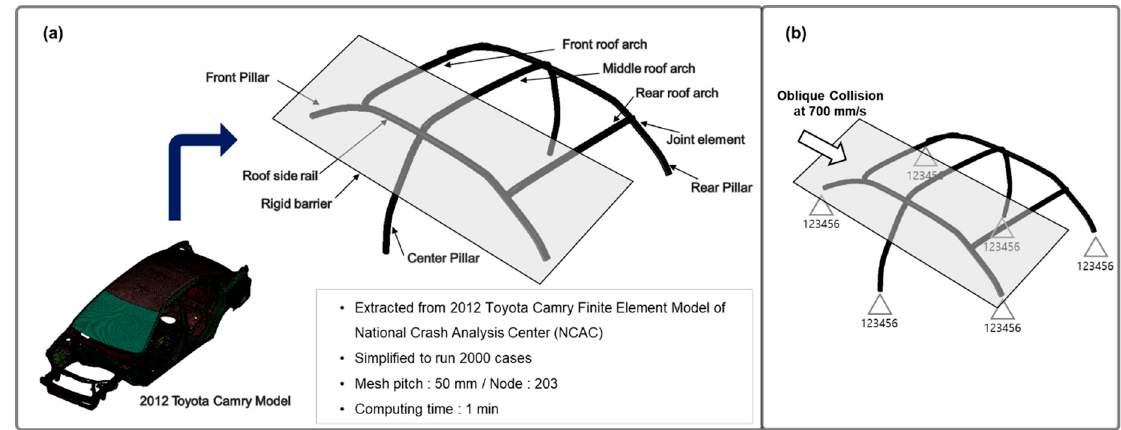
Figure 1. ( a ) Simplified finite element (FE) roof crush model from 2012 Toyota Camry model [21], ( b ) Oblique collision to simulate the rollover-driven roof impact and boundary conditions. Table 2. Design variables of optimization for 2000 body-in-white (BIW) models. Parts Variation